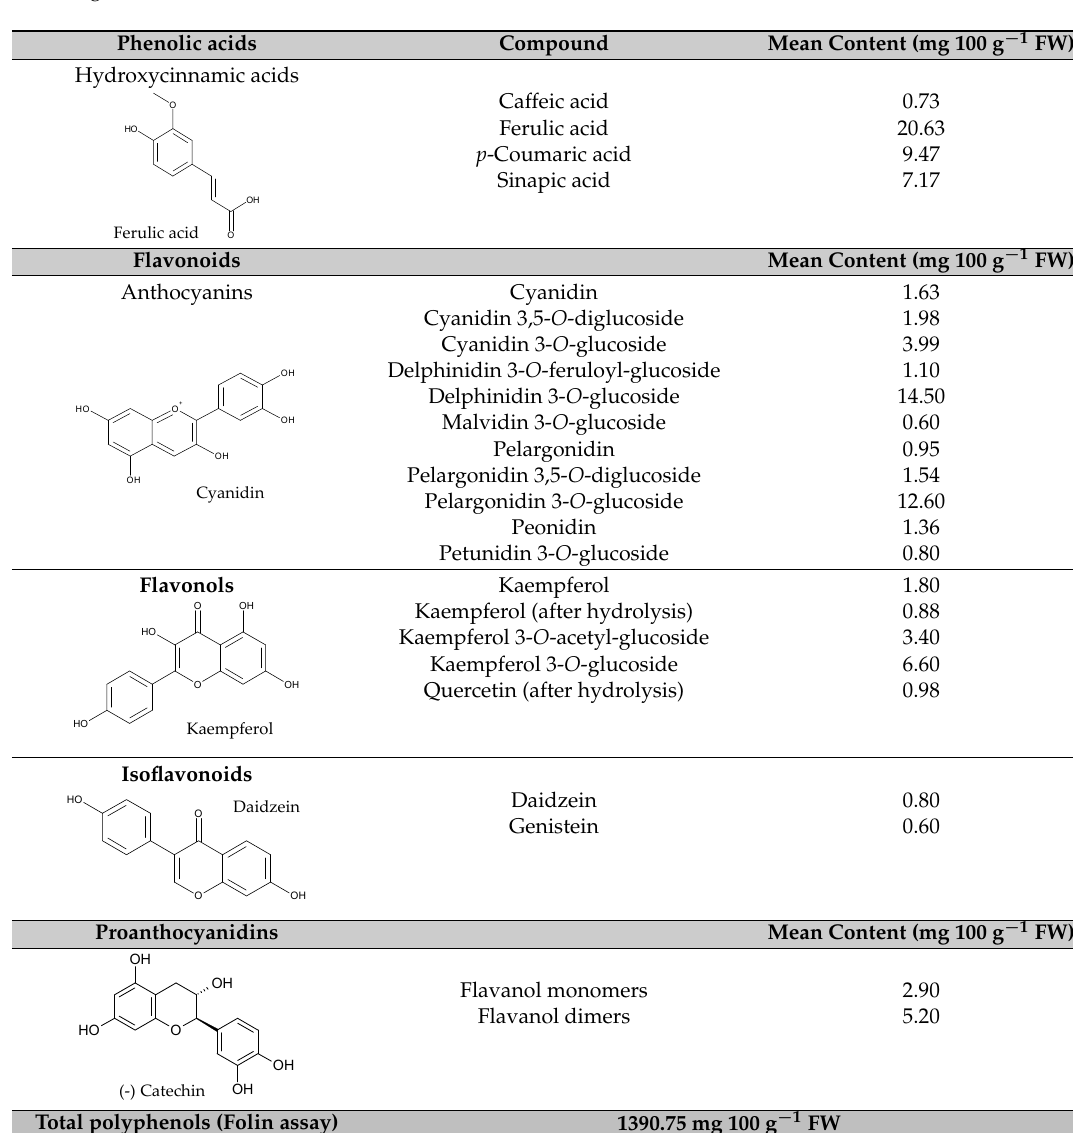
Table 2. Phenolic composition of common bean ( Phaseolus vulgaris L.), black, whole, raw on fresh weight (FW) basis *.